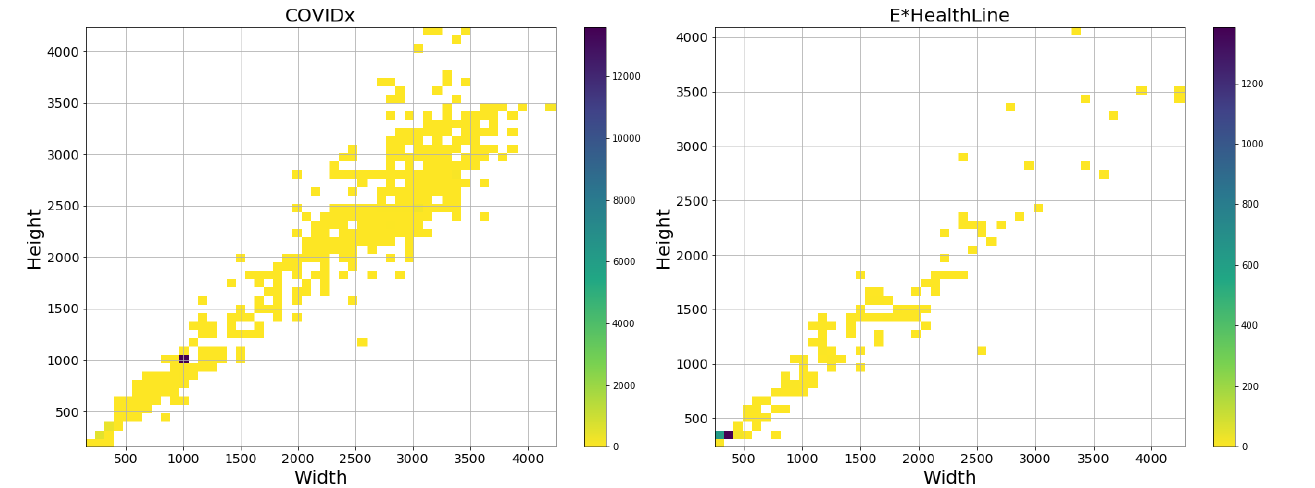
Figure 2. Range of image resolutions of the COVIDx ( left ) and EHL ( right ) datasets. A high concentration of images in the COVIDx dataset is centered around 1000 × 1000 pixels, but the majority of EHL images is below 480 × 480 pixels.